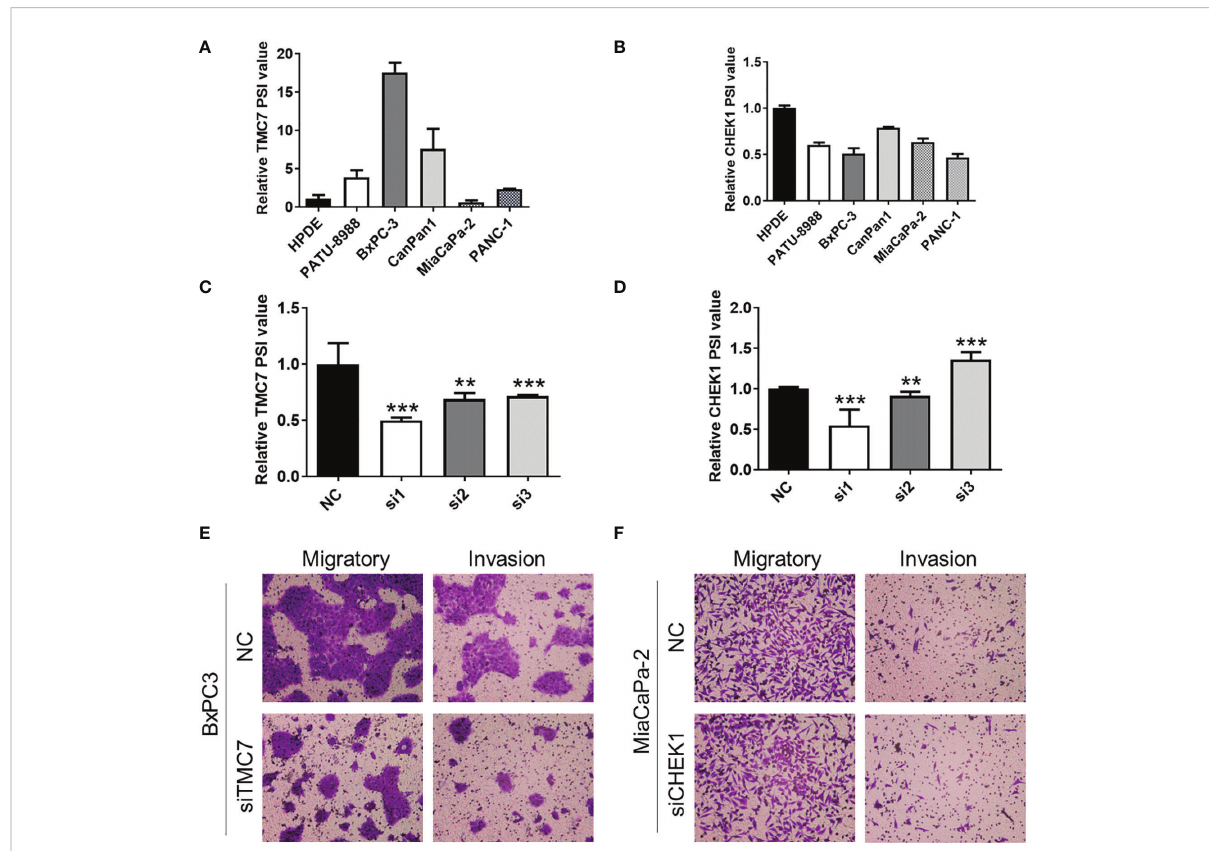
FIGURE 5 Knockdown of exon 17 of TMC7 inhibits invasion and migration of pancreatic cancer cells. (A) Expression of TMC7 AS events in pancreatic cancer cell lines and normal pancreatic cell lines by qRT-PCR. (B) After treatment by siRNAs targeting TMC7 exon 17, RNA levels of TMC7 exon 17 and exon 16 were detected by qRT-PCR. (C) After treatment by siRNAs targeting TMC7 exon 17, migratory and invasion abilities were assessed. (D) Expression of CHEK1 AS events in pancreatic cancer cell lines and normal pancreatic cell lines by qRT-PCR. (E) After treatment by siRNAs targeting CHEK1 exon 13.3, RNA levels of CHEK1 exon 13.3 and exon 13.1 were detected by qRT-PCR. (F) After treatment by siRNAs targeting CHEK1 exon 13.3, migratory and invasion abilities were evaluated. AS, alternative splicing. P value, “ ** ” 0.001-0.01; “ *** ”